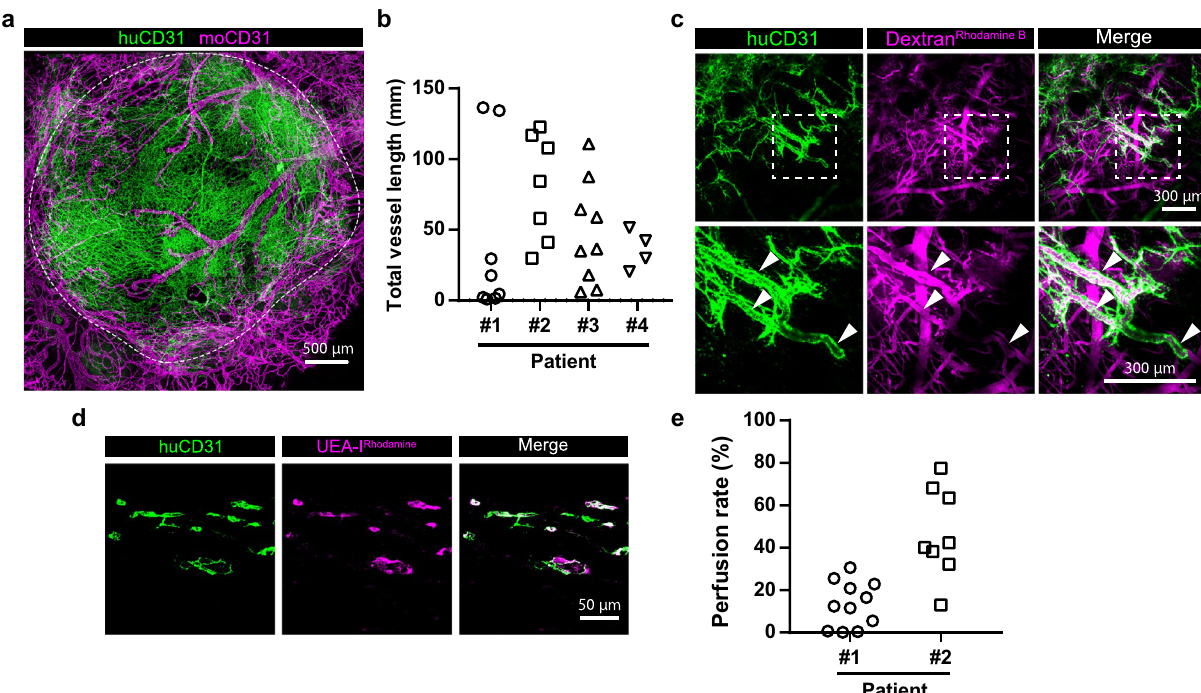
Figure 3. Human tumor-derived human blood vessels in cranial windows. ( a ) Representative image of colon tumor patient-derived human blood vessels (green, huCD31-AF488 Ab injected intravenously) and mouse blood vessels (magenta, anti-moCD31 immunofluorescence staining) in the cranial window. White dashed line shows the edge of the engrafted human tissues on day 19. ( b ) Quantification of total human blood vessel length two weeks after transplantation into cranial the window (Patient #1: n = 8, Patient #2: n = 7, Patient #3: n = 9, Patient #4: n = 4). ( c ) In vivo perfusion of human blood vessels shown by intravenous injection of Rhodamine B-conjugated 70 kDa Dextran (Dextran Rhodamine B , magenta) in the tumor xenograft. Image acquisition was at day 20 after tumor transplantation. Lower images show high magnification of the area indicated by dashed boxes in the upper row. White arrowheads show perfused human blood vessels. ( d ) Perfusion of human blood vessels (green, huCD31-AF488 injected intravenously) in the cranial window was assessed by injecting Rhodamine- conjugated Ulex europaeus agglutinin I (magenta, UEA-I Rhodamine ). ( e ) Quantification of perfused human blood vessels in the cranial window (Patient #1: n = 2, Patient #2: n =